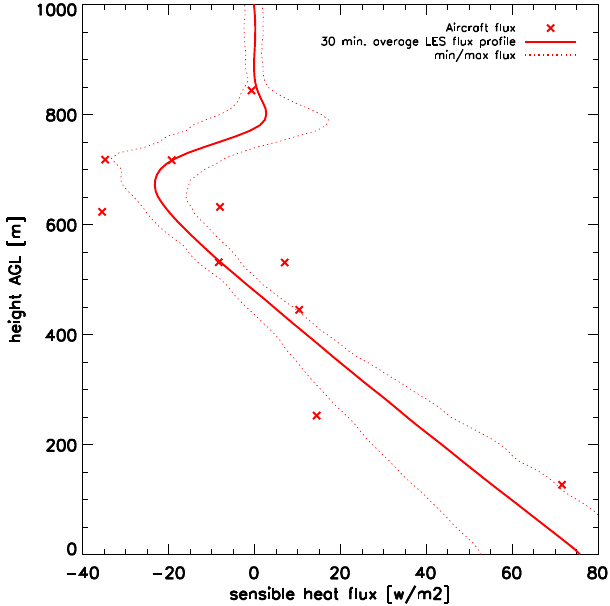
Figure 11. Vertical profile of the sensible heat flux between 14:00 and 15:00UTC. DALES data correspond to Case 2. Dotted lines indicate the minimum and maximum fluxes calculated by DALES during the hour at which the observations are taken